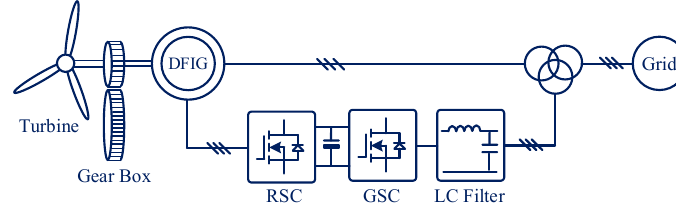
Figure 1. Schematic diagram of the DFIG power conversion system.